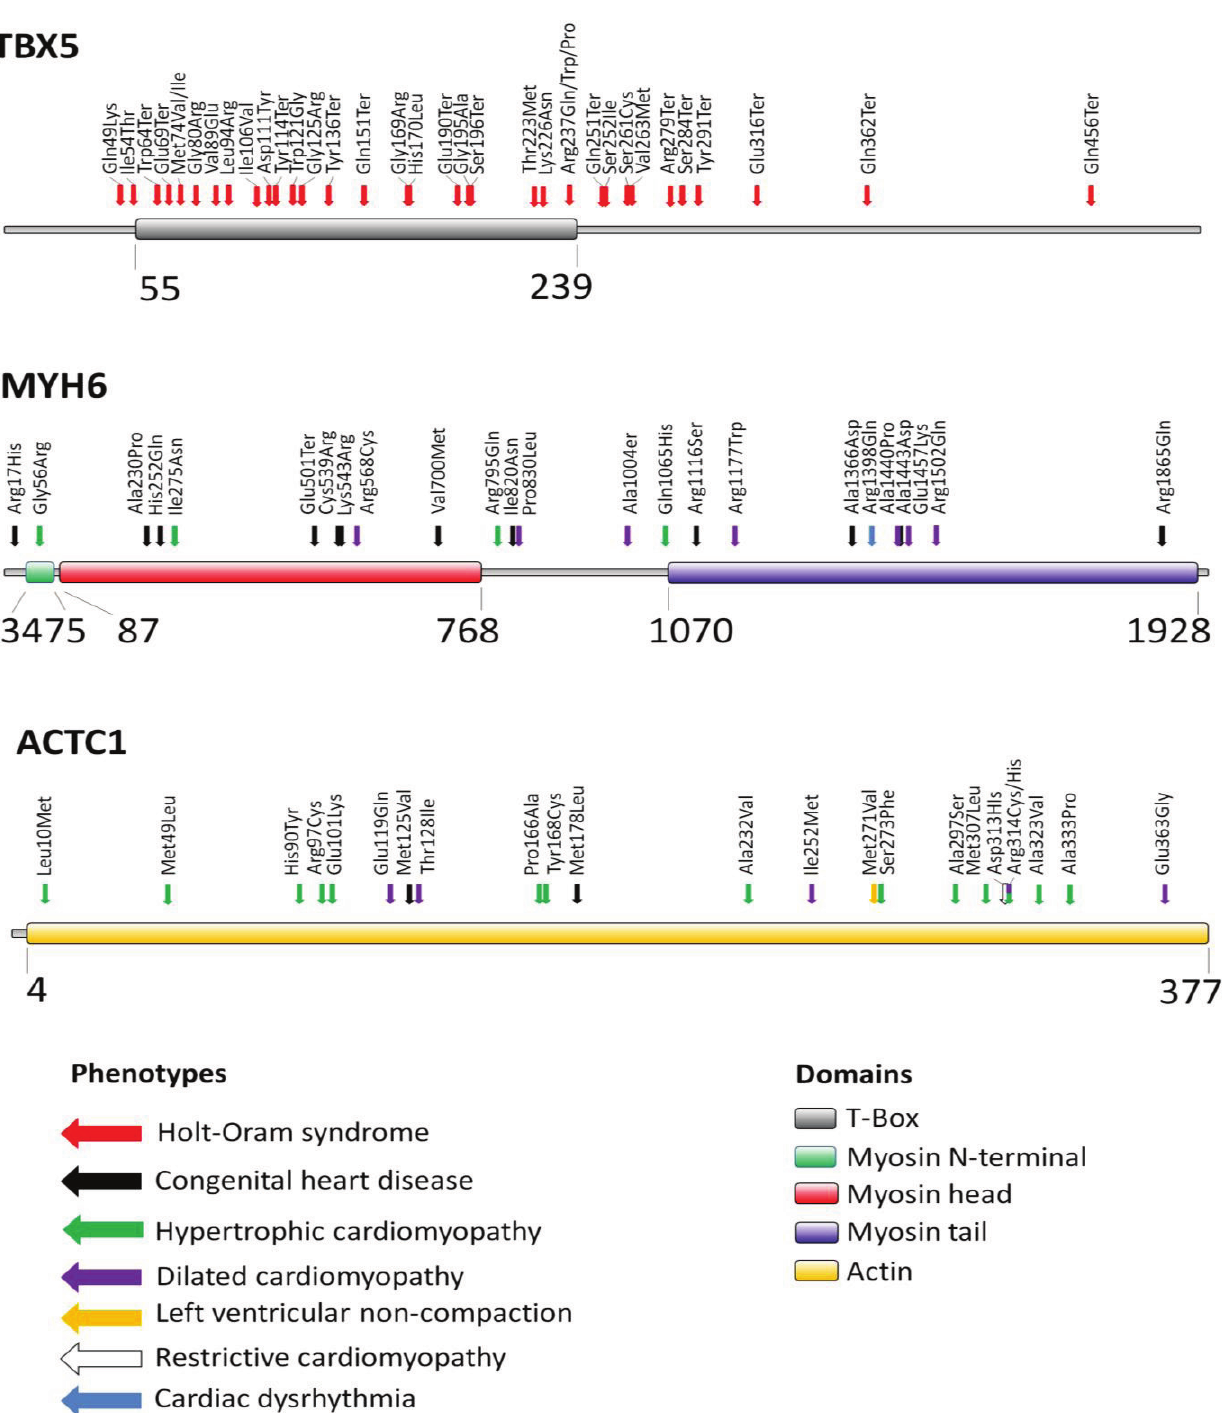
Figure 2. Diagrams representing the TBX5, MYH6 and ACTC1 proteins and the changes induced by mutations described in the genes encoding them. The changes in the amino acid residue sequences are annotated with colour-coded arrows according to the associated phenotypes. The domains recognized within these proteins are also